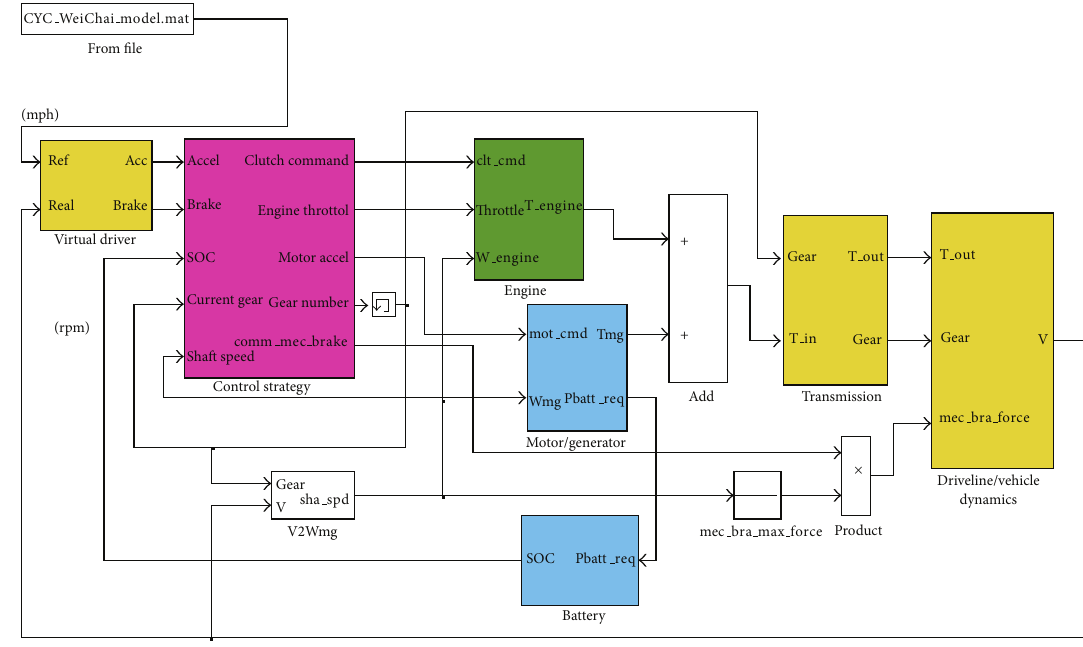
Figure 2: HEV powertrain model in Simulink.